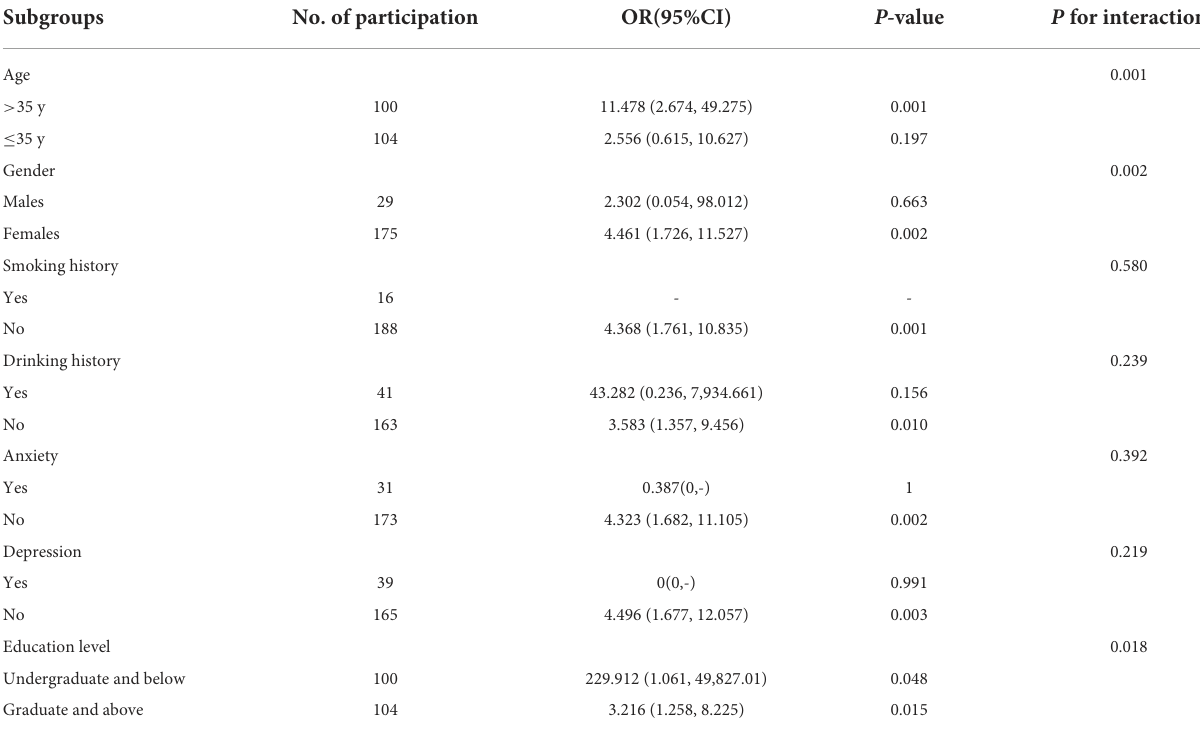
TABLE 3 Effect of poor sleep quality on migraine risk stratified by subgroups.